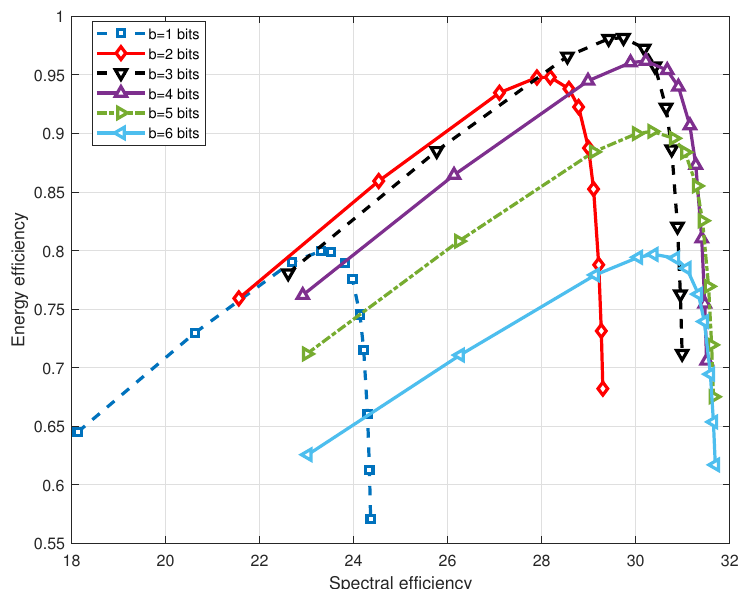
Figure 4. Energy efficiency versus spectral efficiency with the number of quantization bits b = [1:1:6] bits and transmitted power per user p u = [ 0.01,0.02,0.05,0.08,0.1,0.15,0.2,0.3,0.4,0.6,0.8,1 ] W, where each line corresponds to different b and the points on each line correspond to different p u